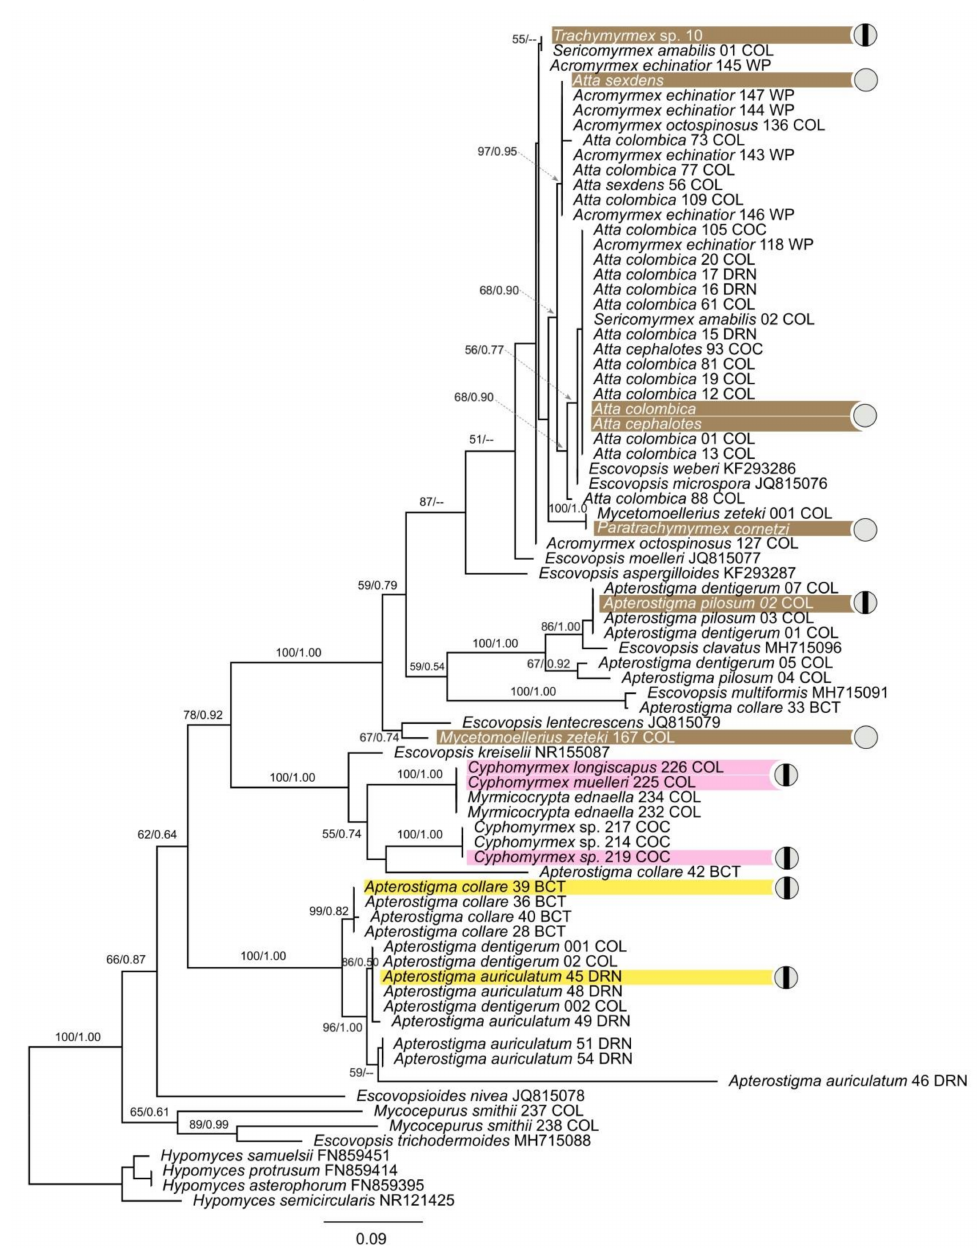
Figure 2. Phylogenetic tree based on ITS rDNA sequences of Escovopsis strains from fungus-growing ant gardens. The phylogenetic tree shown is based on the maximum likelihood tree topology. Escovopsis strains isolated from lower attine colonies ( Apterostigma auriculatum , Ap . collare , Ap . pilosum , Cyphomyrmex longiscapus , C . muelleri and Cyphomyrmex sp.) and strains isolated from derived attine colonies ( Trachymyrmex sp10 , Mycetomoellerius zeteki , Paratrachymyrmex cornetzi , Atta colombica , At . cephalotes and A . sexdens) . Each strain isolated as part of this study is indicated by the species name of the ant host garden from which the Escovopsis was isolated, and all other strains are indicated by their genus and species name, followed by the Genbank accession number. Hypomyces species were used as outgroups. Bootstrap supports ( ≥ 50%) of ML and the posterior probability values ( ≥ 0.5) of BI analyses are indicated above or below the respective branches. Branch color indicates fungal spore color. The provinces from which each strain was isolated are indicated by the abbreviations detailed in Figure 1. Closed grey circles show intermingling, a non-antagonistic form of interaction, while split grey circles mean inhibition, a form of antagonistic interaction. Scale bar represents 0.09 substitutions per